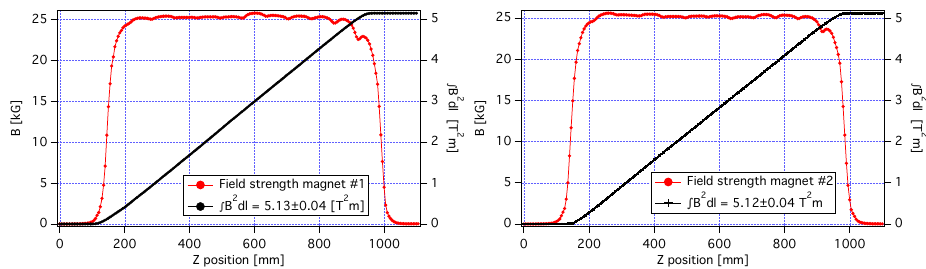
Figure 14. In red are the measured dipolar field profiles of the two PVLAS-FE magnets. The values (cid:82) B 2 dL are reported in of ext